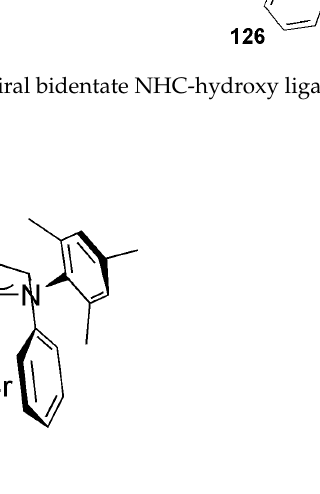
Figure 10. Structure of a magnesium NHC ‐ phenoxy chelate [154].